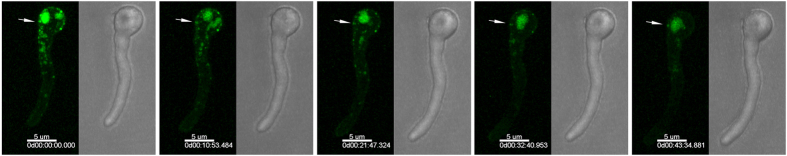
AnNce102 forms stable structures with low mobility.Images were acquired every 150 seconds. White arrow indicates representative AnNce102 spot that remains stable more than 39 minutes. Scale Bars 5 μm.